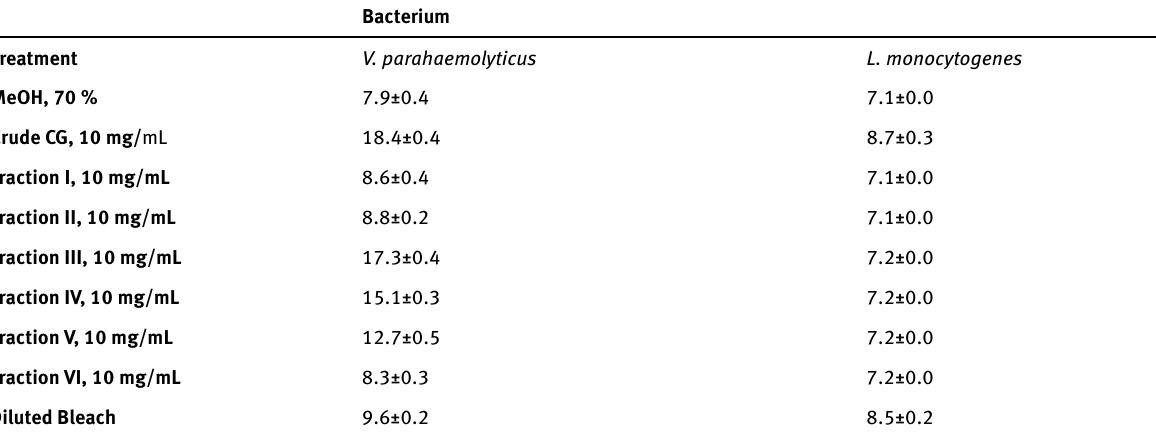
Table 3: Diameters of inhibitory zones (mm) formed by CG crude extract and fractions against V. parahaemolyticus and L. monocytogenes cultures on tryptic soy agar, after 24 h incubation at 37 ± 1°C